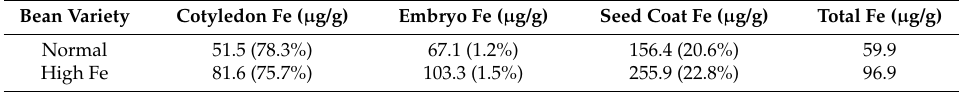
Table 2. Iron content of cotyledon, embryo and seed coat of the normal and high Fe beans 1 .